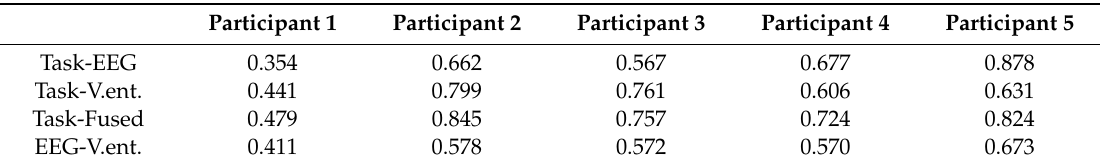
Table 4. Notable correlation coe ffi cients for each participant (Task = task index, EEG = EEG